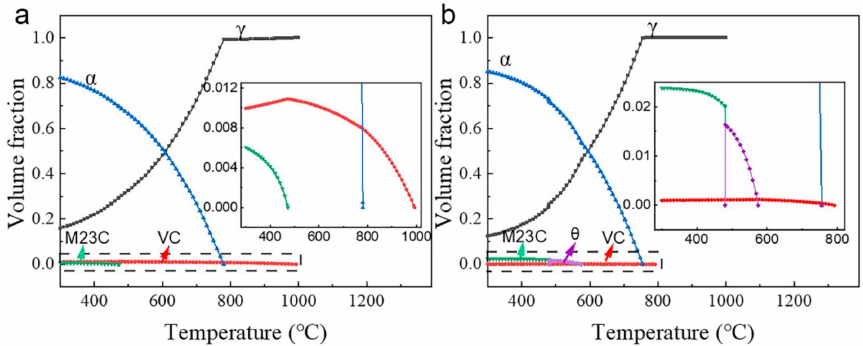
Figure 2. Equilibrium phase diagrams of ( a ) HV steel and ( b ) LV steel. The insets are the enlarged images in the dashed boxes of the corresponding